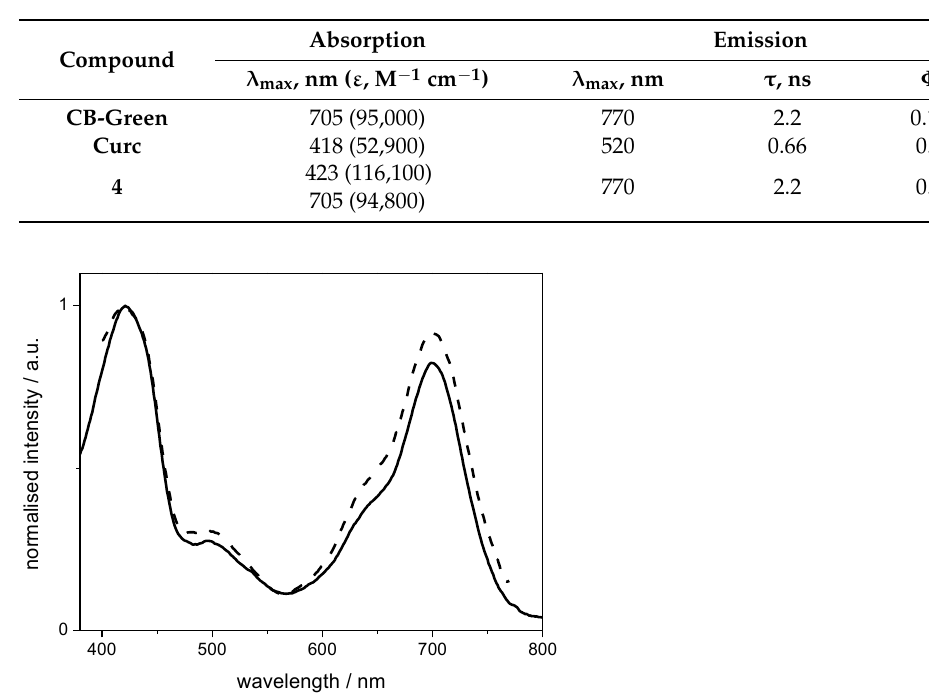
Table 1. Spectroscopic data of the bichromophoric CB-Green species and the subunits Curc and 4 , recorded from acetonitrile solutions.